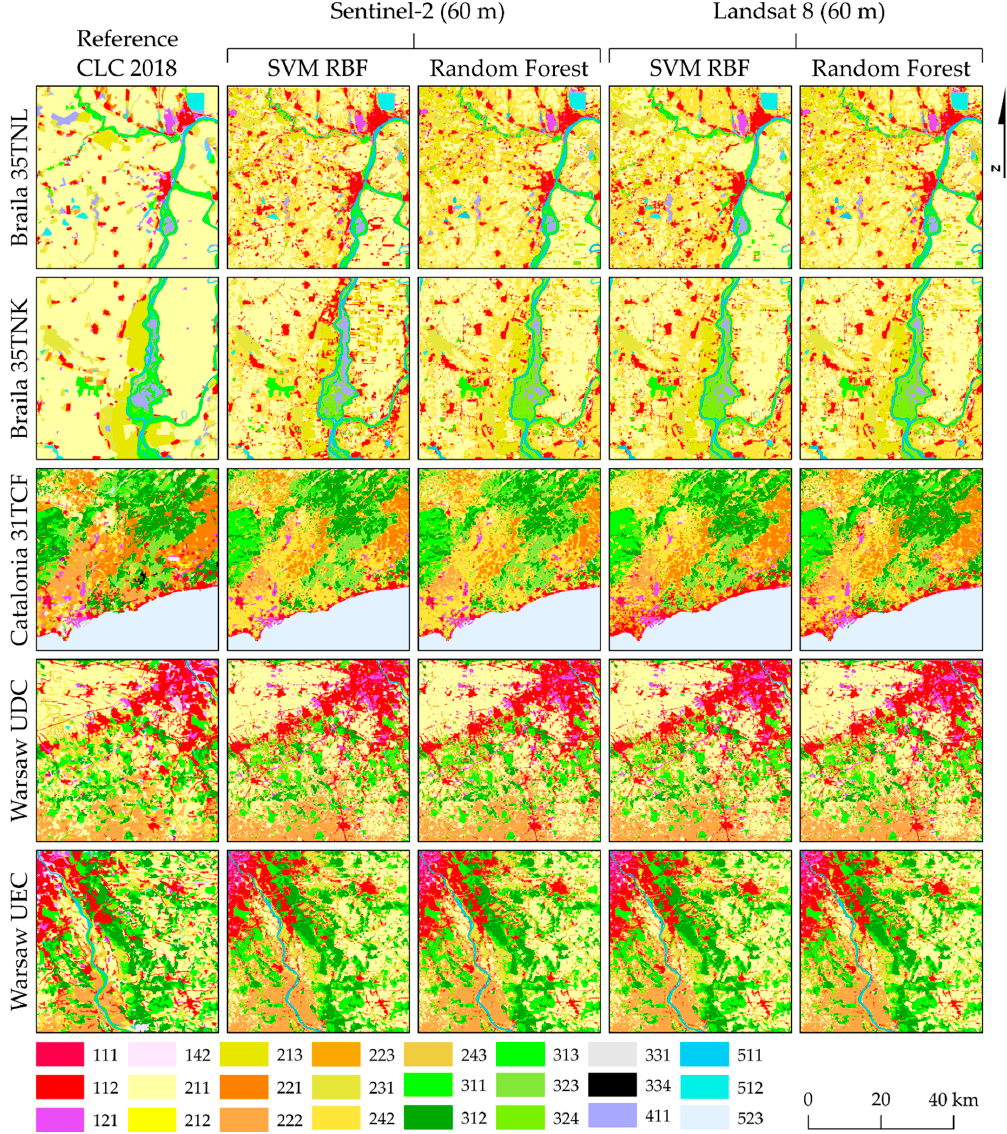
Figure 8. Reference Corine LC map and outcomes of different classification sets and algorithms.